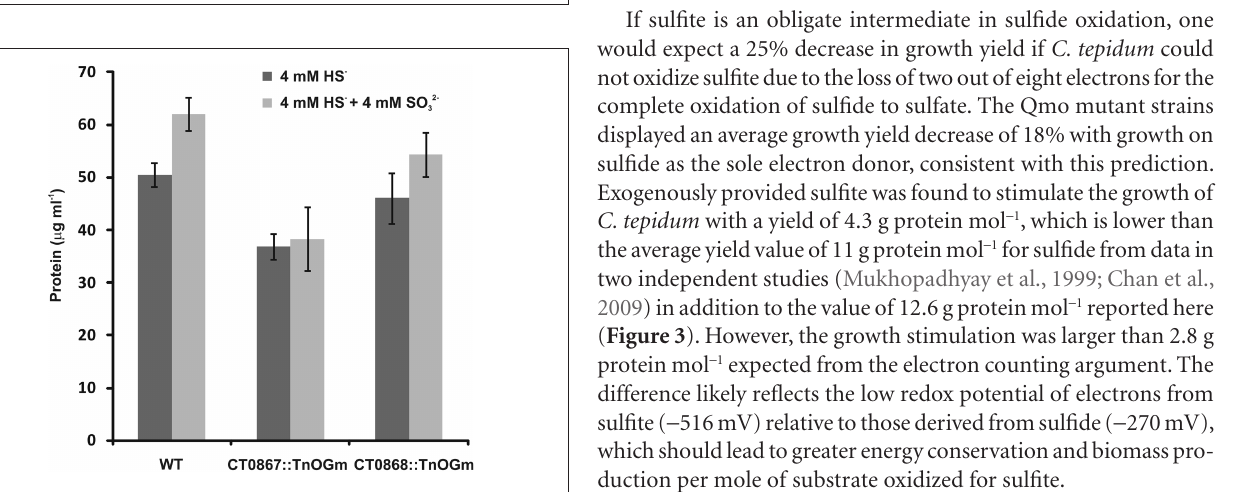
FiGurE 3 | Sulfite stimulation of C. tepidum growth. Sulfide limited (4 mM initial concentration) batch cultures were amended with the indicated concentrations of sulfite and the protein concentration determined in stationary phase. Data points are the means ± SE of three independent cultures for each concentration. The dashed line is a linear regression of the data that results in the equation [Protein] = 4.3[SO 32 − ] + 50.8.